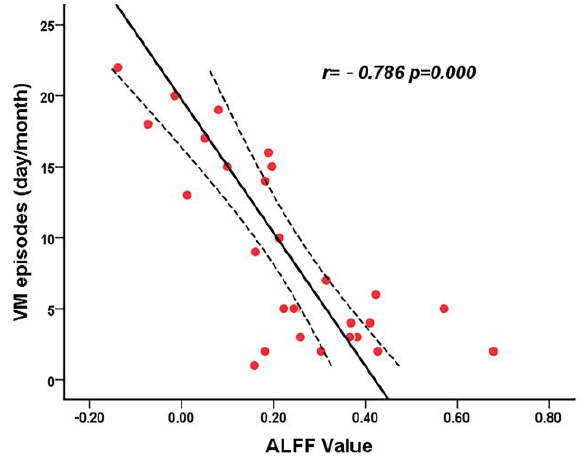
Figure 3. Correlation between the altered ALFF of the left thalamus and the frequency of VM attacks in patients with VM. Each Red dot denotes a sample. The solid line indicates the approximate line using partial correlation method. Smoothing curves represent the 95% of confidence intervals from the fit .